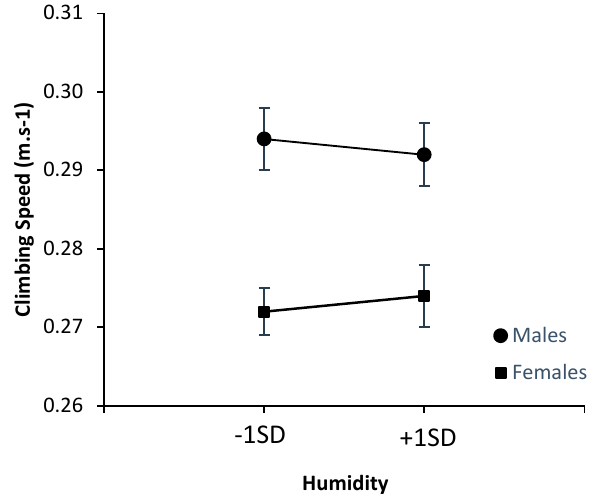
Figure 4. Effects of temperature on climbing speed (m·s − 1 ).